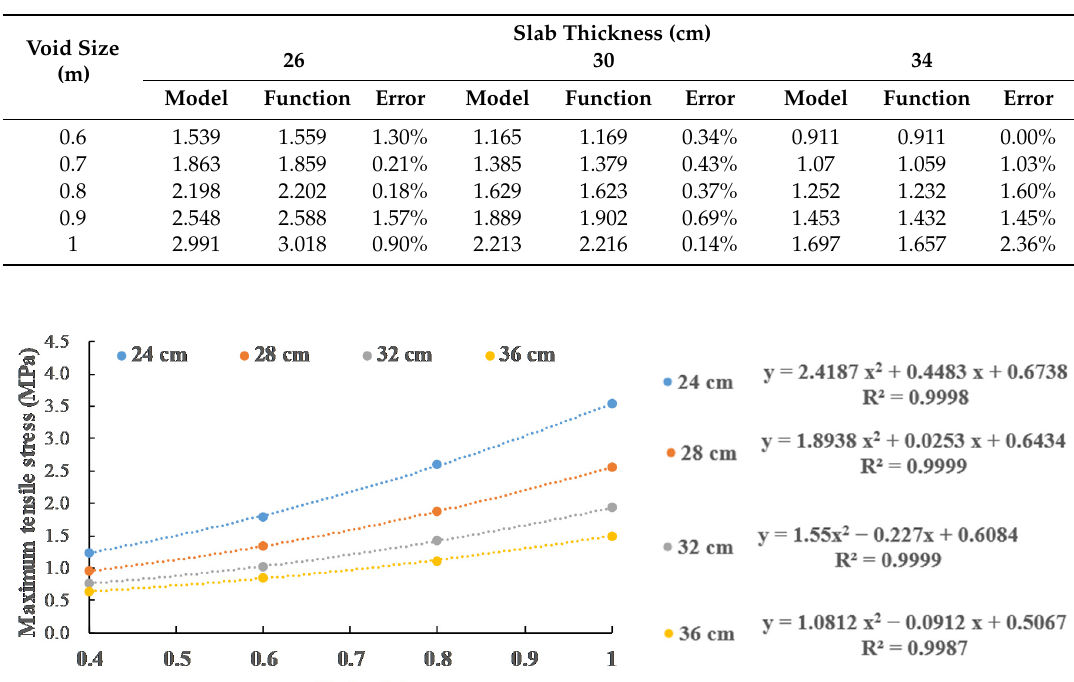
Table 3. Comparison between simulation results and function calculation results.